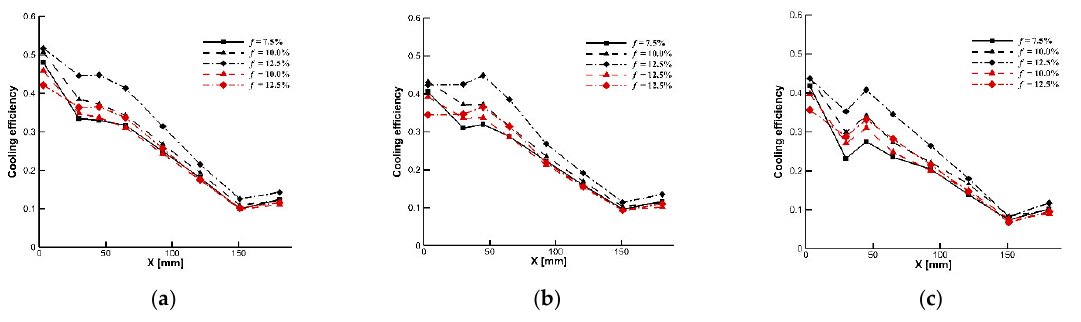
Figure 7. Transformed cooling efficiency along the axial direction. ( a ) α = 0°. ( b ) α = 15°. ( c ) α = 30°. Slot width θ is an important structural parameter of film orifices in discrete slots, which directly affects the outlet area of film orifices and the initial distribution of film cooling. The excessive slot width will have a negative impact on the structural integrity and the outlet ve- locity of the film medium. In this regard, two widths, including θ = 6.37° and θ = 12.74°, are studied in this